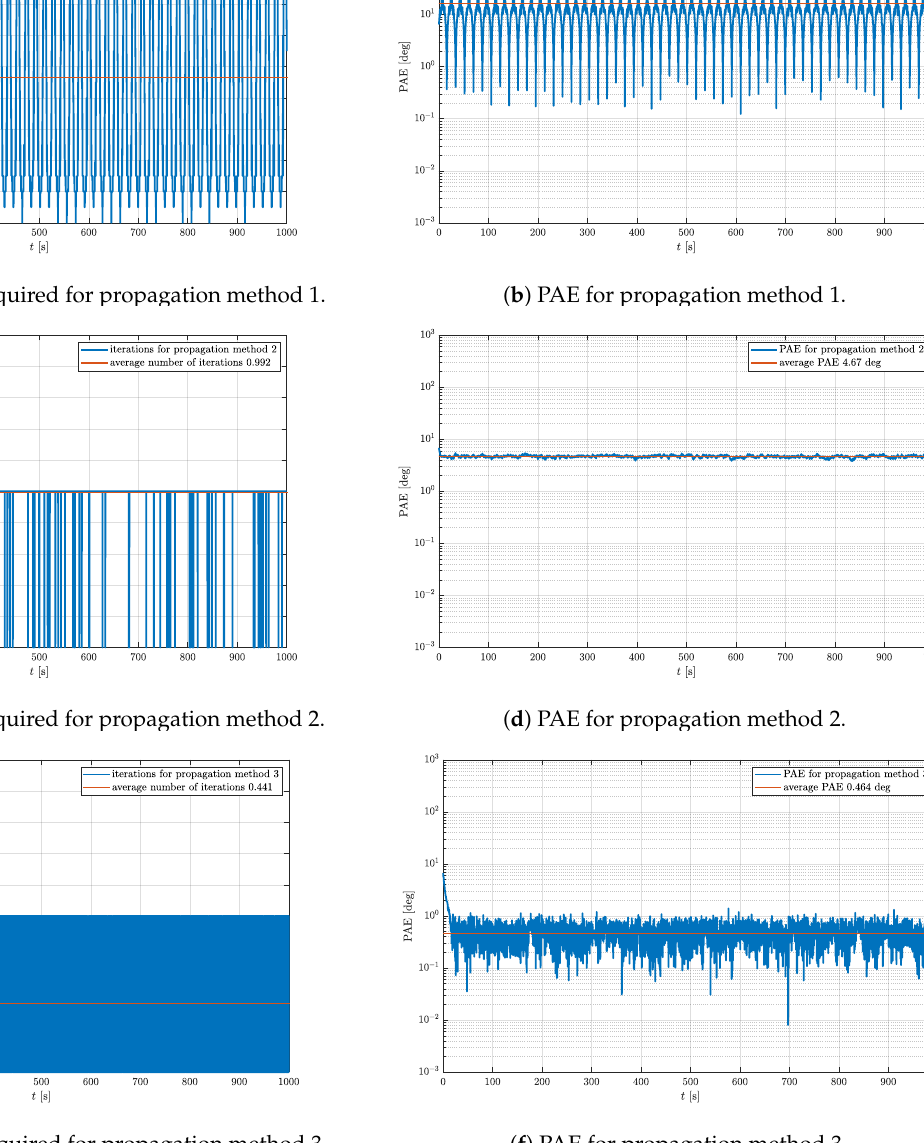
Figure 7. Comparison of number of iterations and PAE for different propagation methods